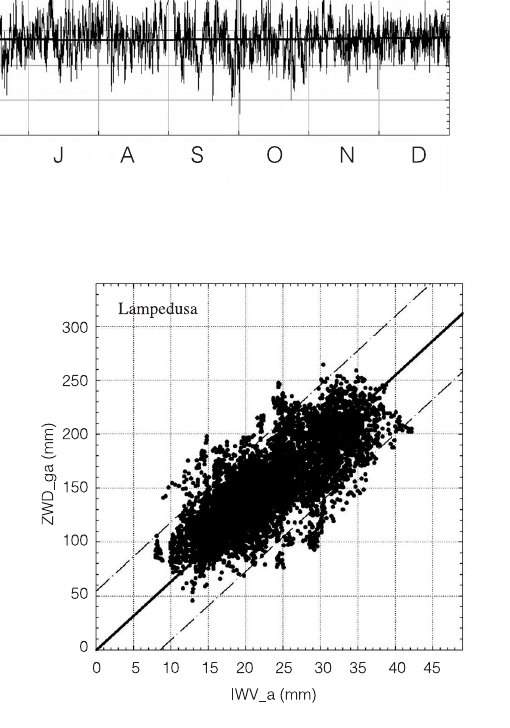
Fig. 3. GPS ZWD and sun photometer PW scatter plot. Fig. 4. GPS ZWD and HIRLAM IWV scatter